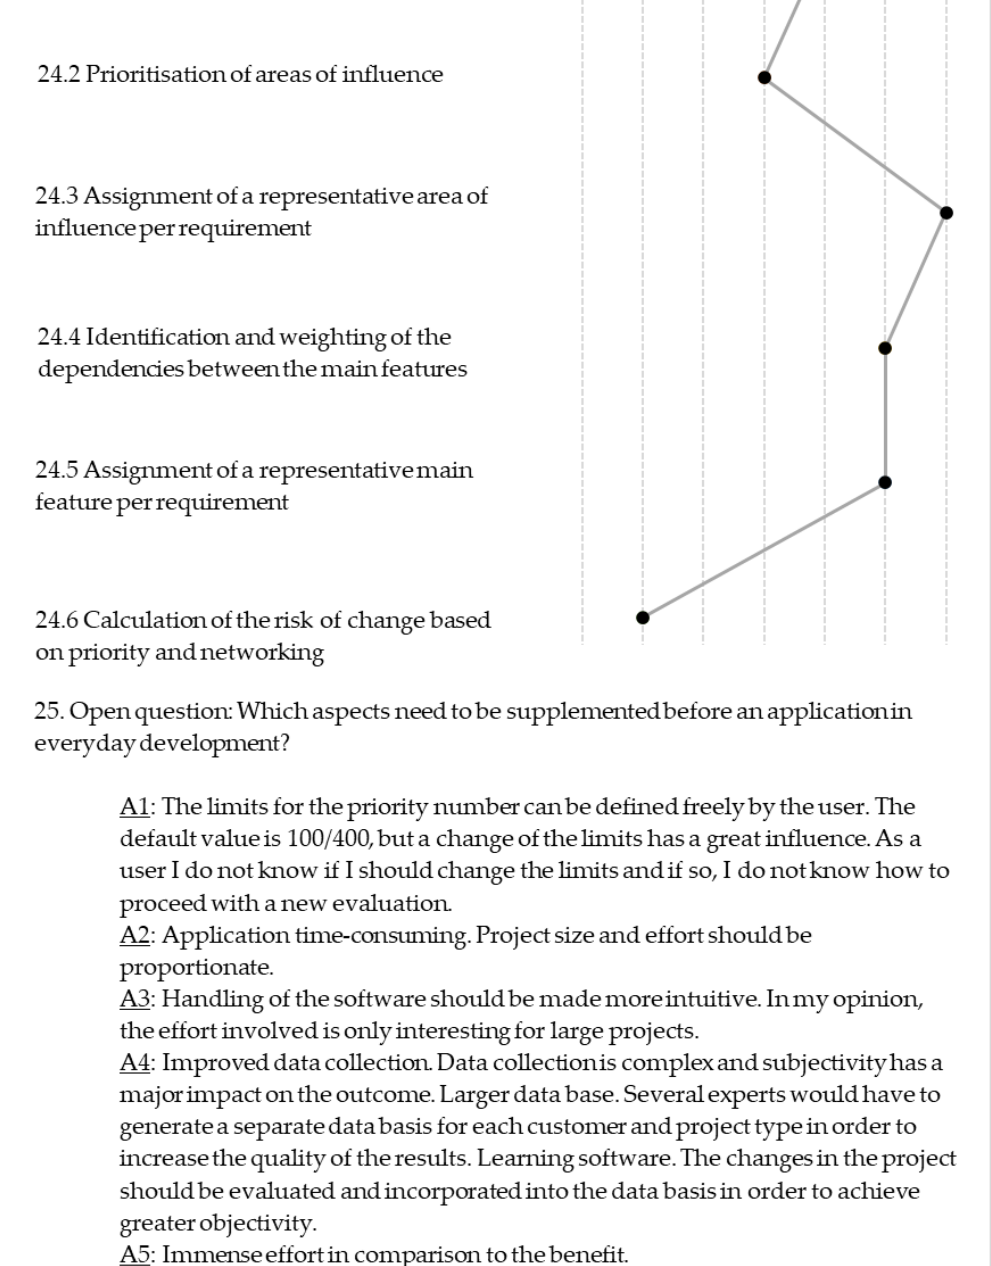
Figure A3. Questionnaire results on area “method for systematic assessment of requirement change risk” – Part II/II.